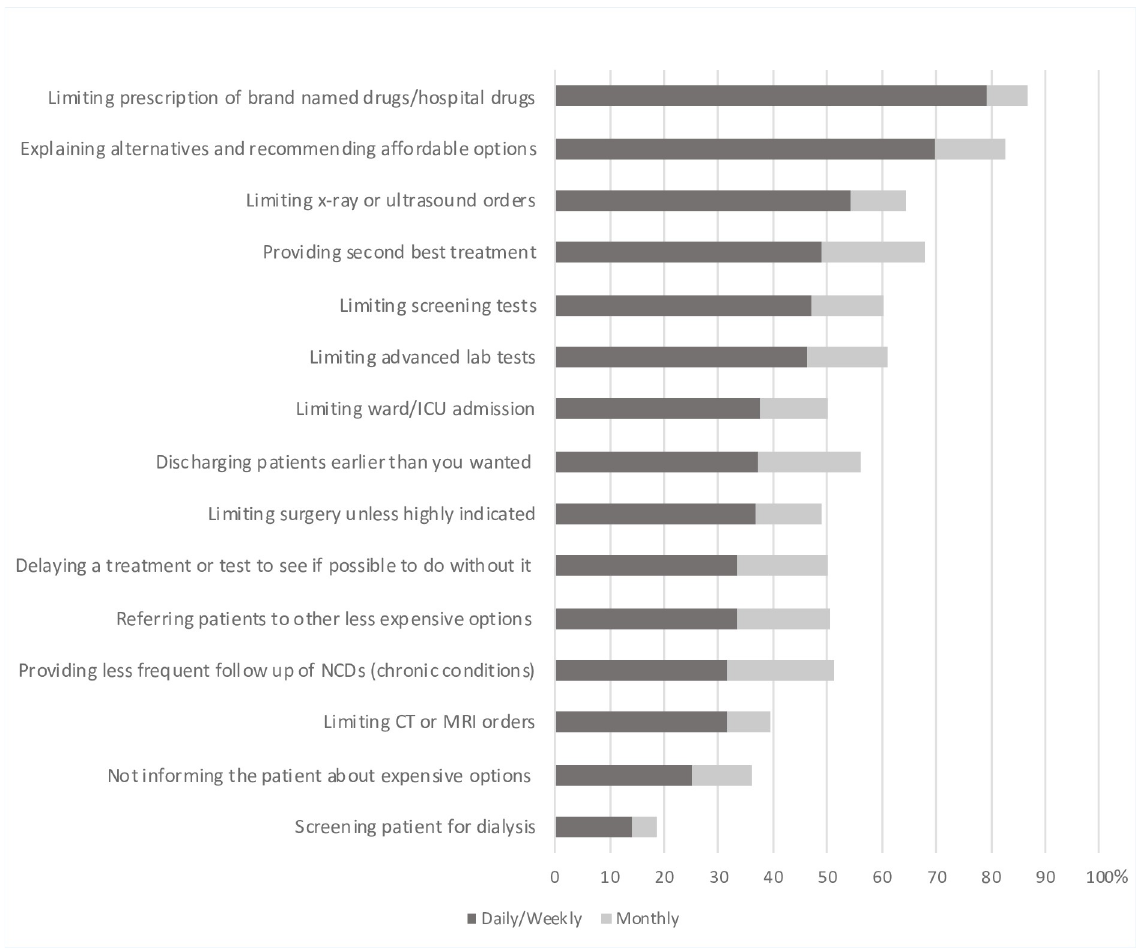
Fig 2. Strategies Used by Physicians to reduce costs for the patient and family. Shown by descending order of daily/weekly use.